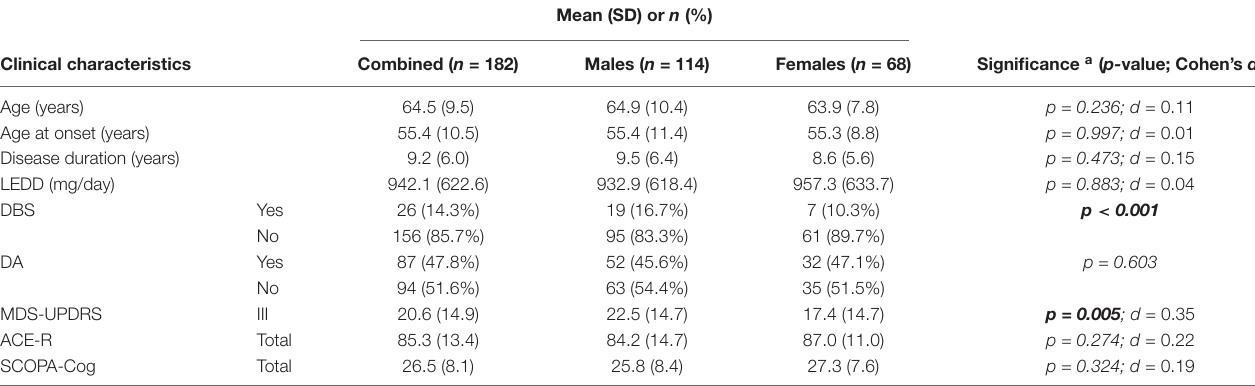
TABLE 1 | Clinical characteristics of the PD cohort used in this study, when combined and when compared by sex.